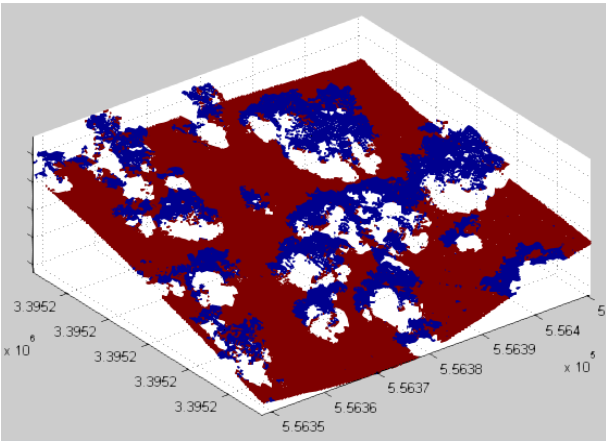
Figure5: merged segmented image on point cloud